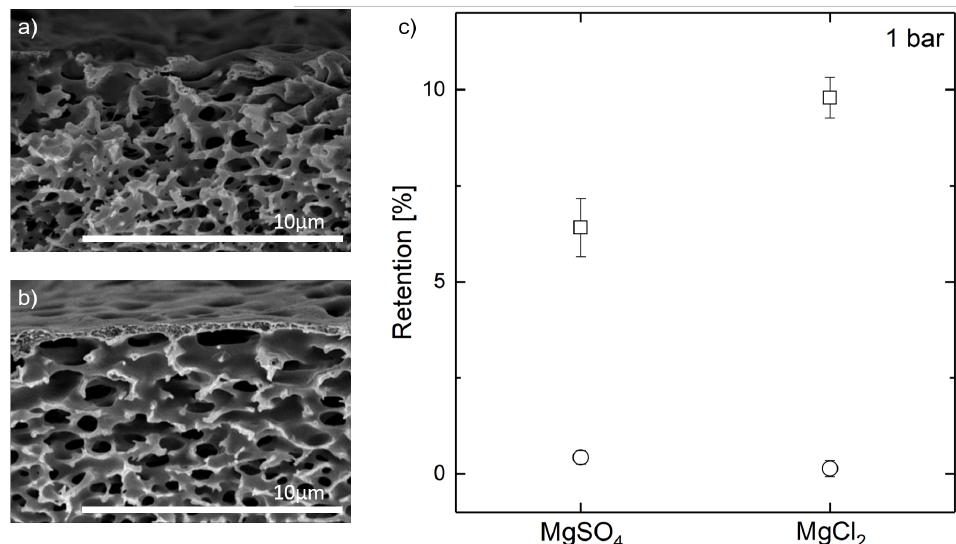
Figure 5. FESEM imaging of a polyethersulphone commercial membrane support structure. ( a ) with- out polyelectrolyte coating, and ( b ) with three bilayers PDADMAC/PSS with air-filled support during polyelectrolyte complexation. ( c ) Retention of MgCl 2 and MgSO 4 at 1 bar TMP of a non- coated membrane (circles) and a hollow fiber coated with five bilayers of PDADMAC/PSS with simultaneous wetting control by air back-pressure (rectangles). Experiments were performed on three membrane modules